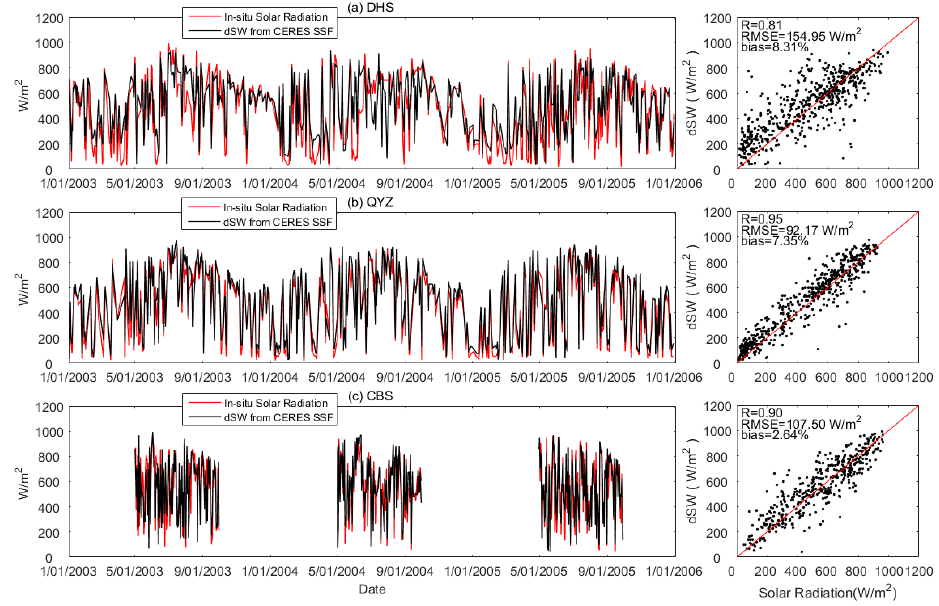
Figure 3. Time series and scatter plots of in-situ measured solar radiation (averaged over 2 h around the satellite overpass) and matched surface downward shortwave radiative fluxes (dSW) from CERES SSF under all-sky conditions.